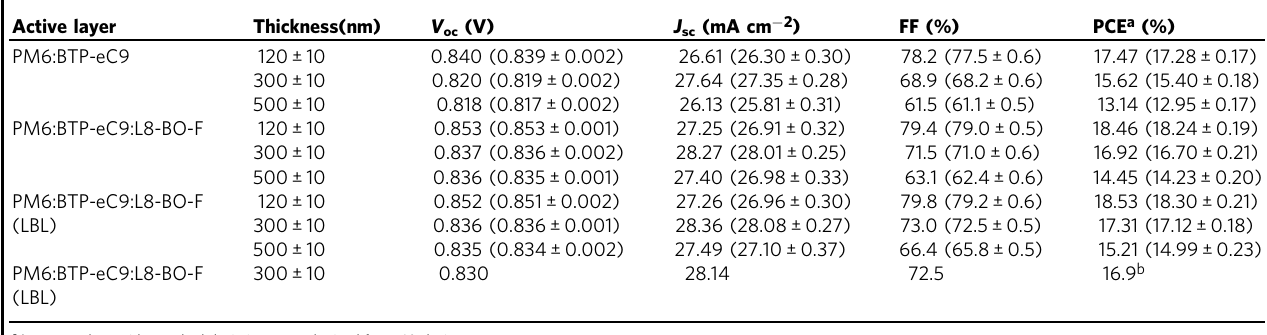
Table 1 Summary of photovoltaic parameters of the PM6:BTP-eC9 and PM6:BTP-eC9:L8-BO-F devices with different active layer